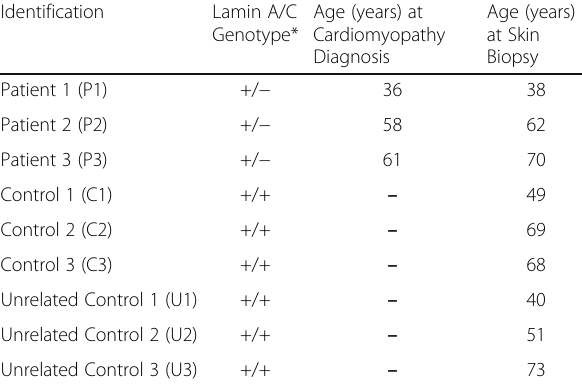
Table 1 Fibroblast cell samples that were RNA sequenced ( N =